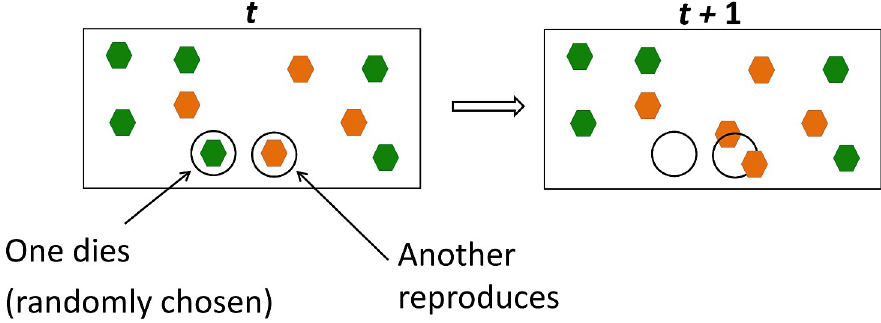
Fig 3. Moran Process with discrete time and directional selection. One of the N cells ( i mutants, in orange, and N (cid:0) i wildtype, in green), present at time t , dies (no preference for type). Its replacement at time t þ 1 is selected from all cells present at t , with odds (relative fitness) r in favor of the mutant. Relative fitness is frequently expressed as r ¼ 1 þ s , where s is called the selection coefficient. For an advantageous mutant, r > 1 , or s > 0